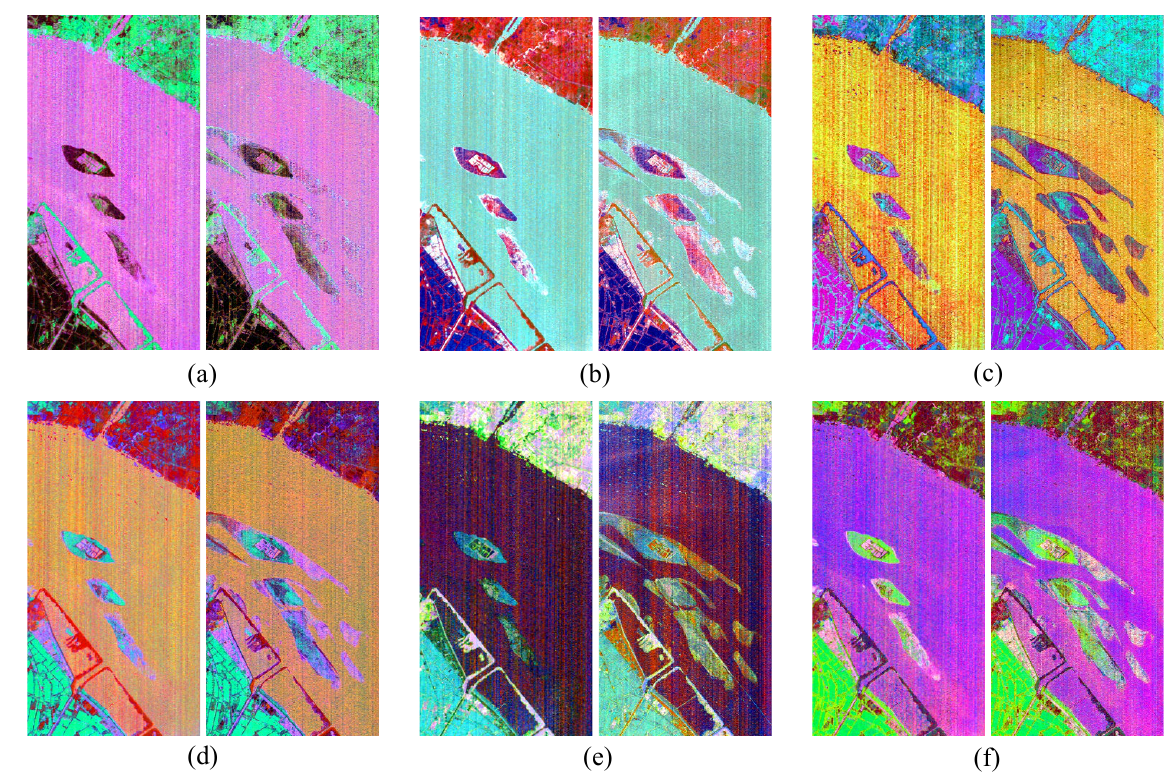
Figure 6. Bi-temporal pseudo color images of projection features by performing: ( a ) DSFA-64-2, ( b ) DSFA-128-2, ( c ) DSFA-256-2, ( d ) ADM-D-PRNs using USFA, ( e ) ADM-D-PRNs using IRMAD, and ( f ) ADM-D-PRNs using PCA, on dataset ‘River’.